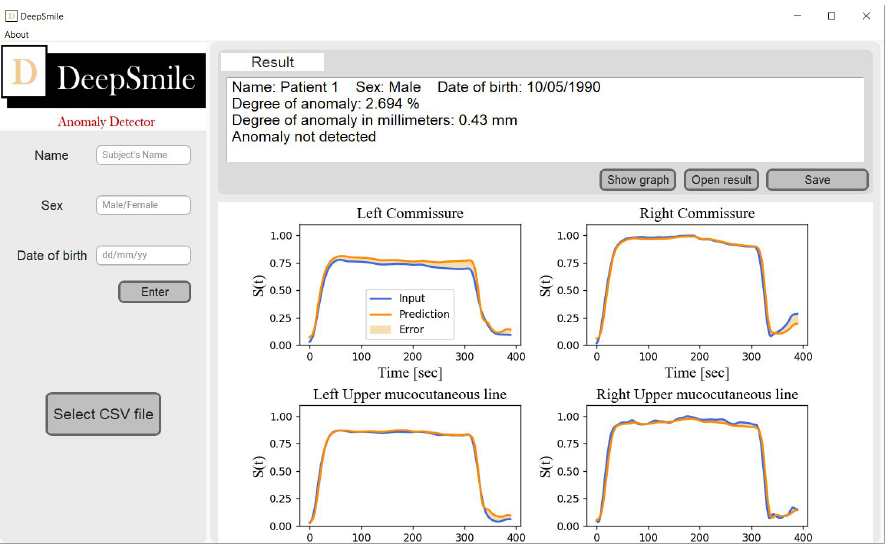
Figure 8. DeepSmile’s graphical user